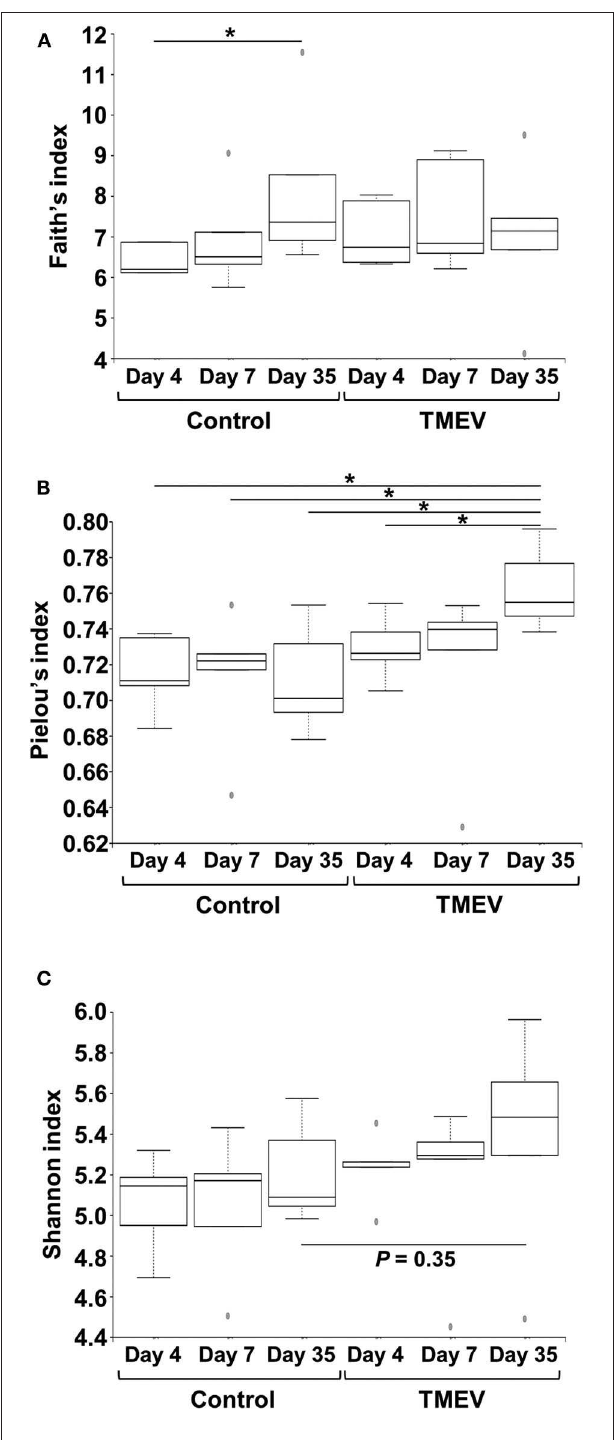
FIGURE 3 | Time course analyses of bacterial alpha diversities of microbiome among TMEV-infected and control groups. Using QIIME 2, we compared the number of genera, evenness, and the combination of them between the groups ( n = 5) by Faith’s phylogenetic diversity index (A) , Pielou’s evenness index (B) , and Shannon index (C) , respectively. (A) The numbers of bacterial (Continued)